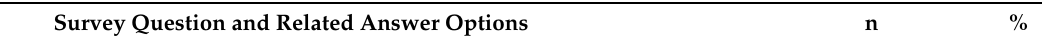
Table 2. Respondent behaviour during walks in relation to location, who they walk with, and whether or not they stay on